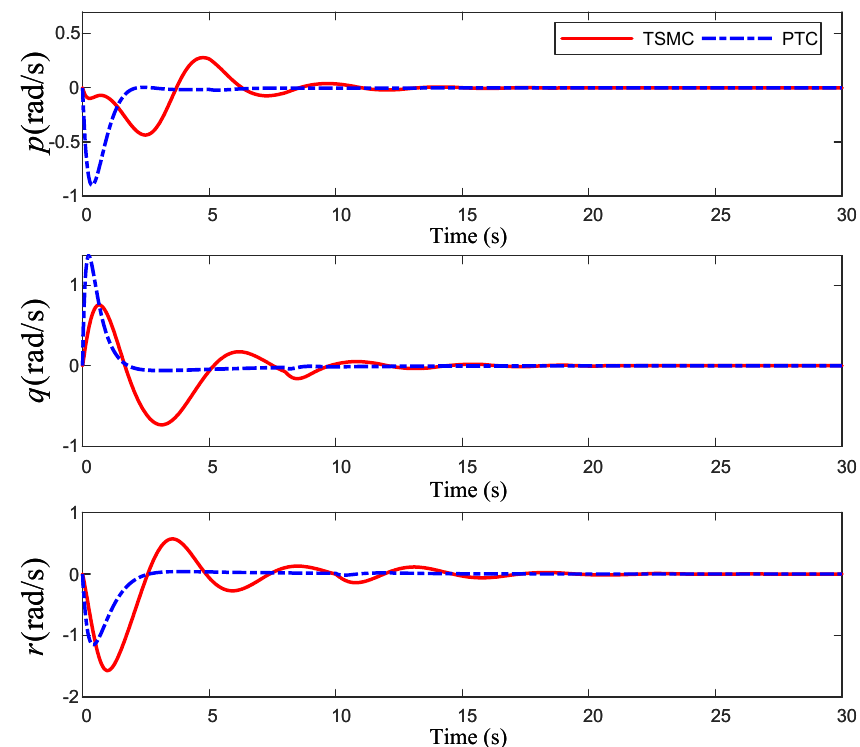
Figure 6. The response of angle velocities